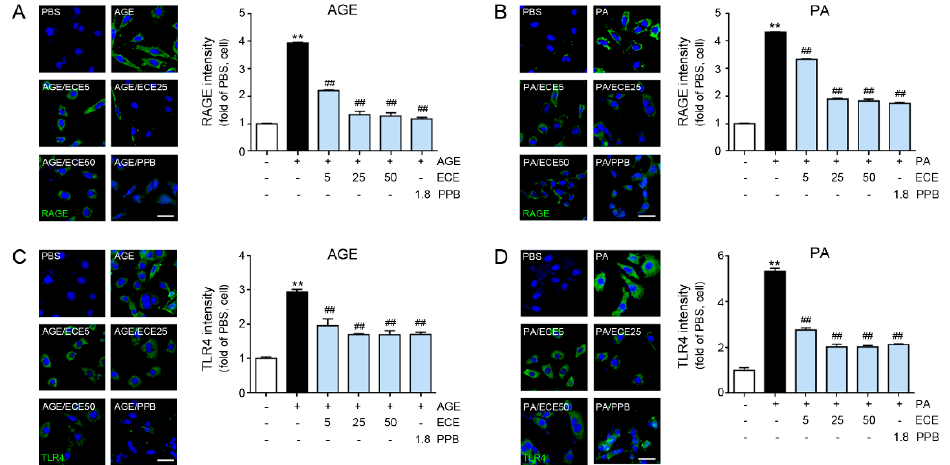
Figure 2. Comparative analysis of concentration-dependent ECE and PPB treatment on the reduction of RAGE and TLR4 receptor expression level in AGE or PA-treated VSMC. ( A , B ) Confocal fluorescence microscopic images demonstrating RAGE expression (green) and nuclei (DAPI, blue) in AGE or PA-treated VSMC. Quantitative graphs demonstrating RAGE intensity from representative images. Scale bar = 50 μ m. ( C , D ) Confocal fluorescence microscopic images demonstrating TLR4 expression (green) and nuclei (DAPI, blue) in AGE or PA-treated VSMC. Quantitative graphs demonstrating TLR4 intensity from representative images. Scale bar = 50 μ m; ** p < 0.01 vs. PBS group; ## p < 0.01 vs. AGE or PA group. AGE, advanced glycation end products; DAPI, 4 ′ ,6-diamidino-2-phenylindole; ECE, Ecklonia cava extract; PA, palmitate; PBS, phosphate-buffered saline; PPB, pyrogallol-phloroglucinol-6,6-bieckol; RAGE, receptor for advanced glycation end products; TLR4, toll-like receptor 4; VSMC, vascular smooth muscle cell.